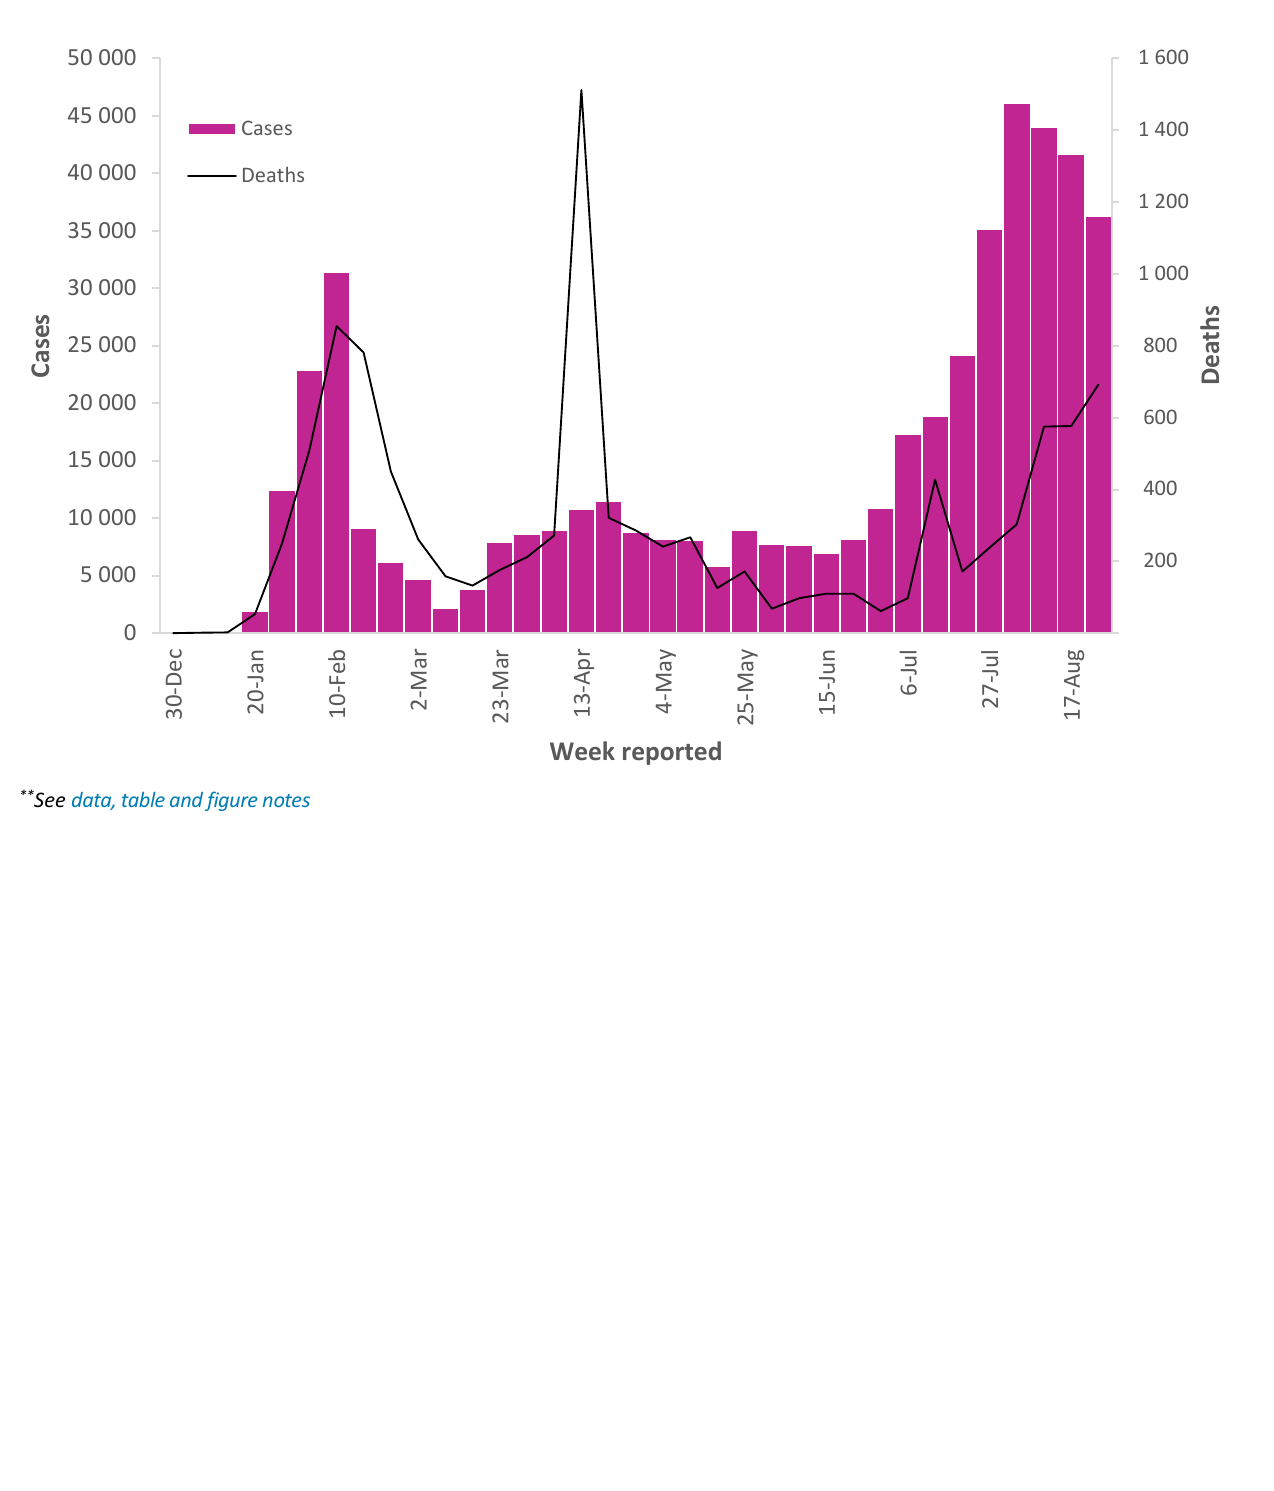
Figure 8: Number of COVID-19 cases and deaths reported weekly by Western Pacific Region, data as of